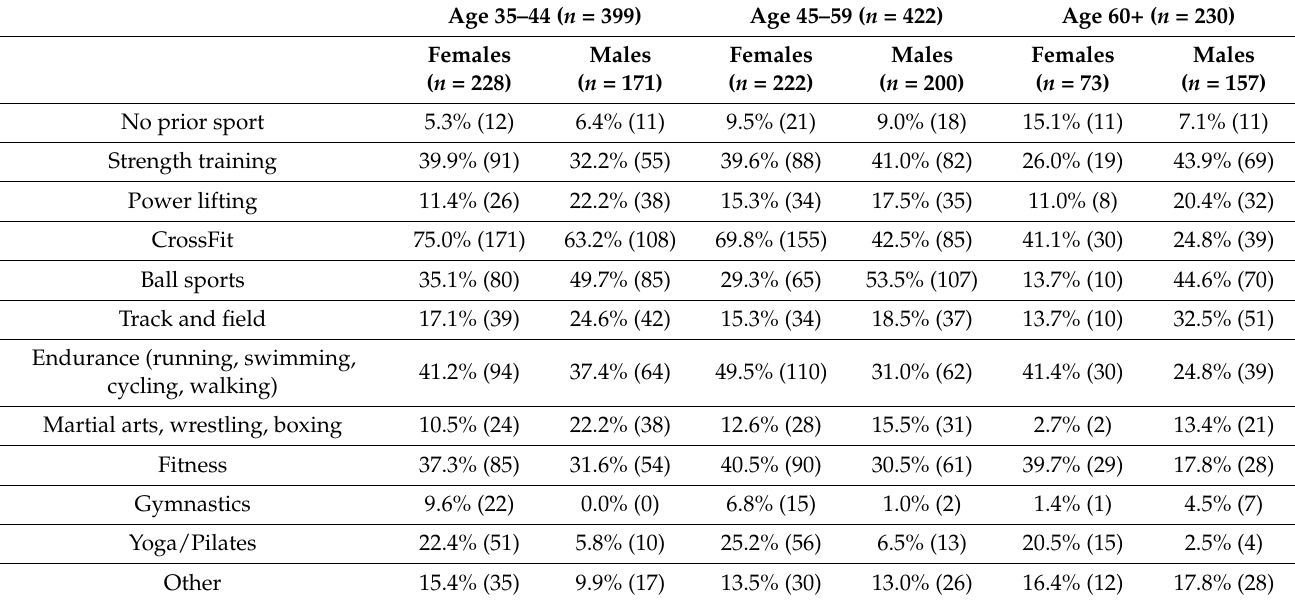
Table 4. Sports prior to weightlifting by age and sex.